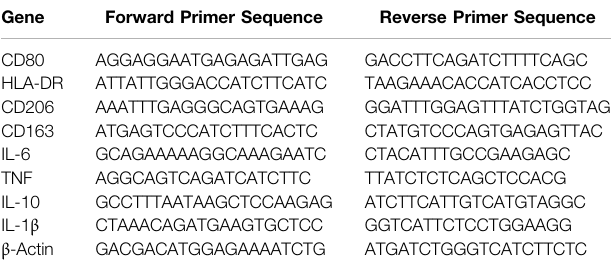
TABLE 1 | KiCqStart SYBR ® Green primer